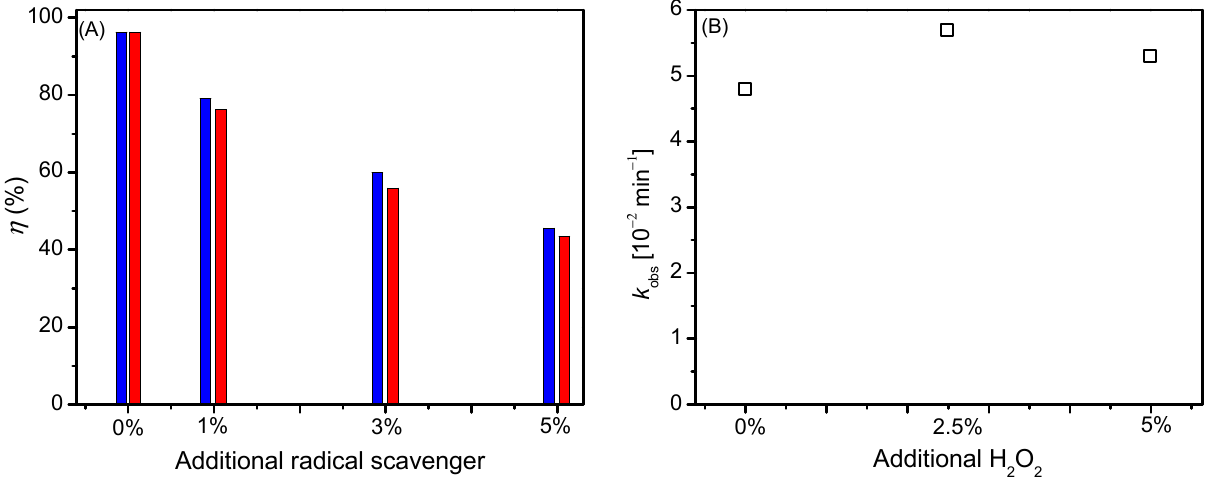
Figure 4. Plots of η values of photodegradation of AO (35.06 µ mol L − 1 ) in aqueous colloidal solution in the presence of 5 mg TiO 2 NPs after irradiation for 30 min with the addition of ( A ) BQ (blue bars) and t-BuOH (red bars), and ( B ) H 2 O 2 .